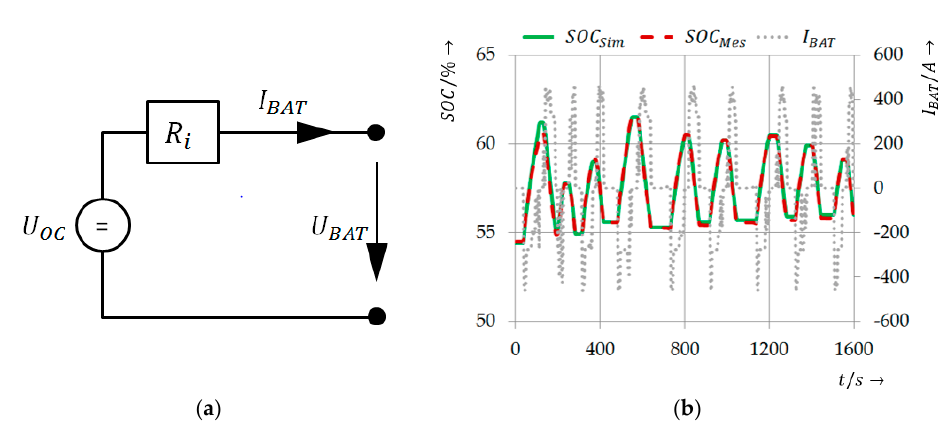
Figure 6. ( a ) Equivalent electric circuit for the battery; ( b ) Battery validation cycle: simulated SOC Sim and measured SOC Mes over